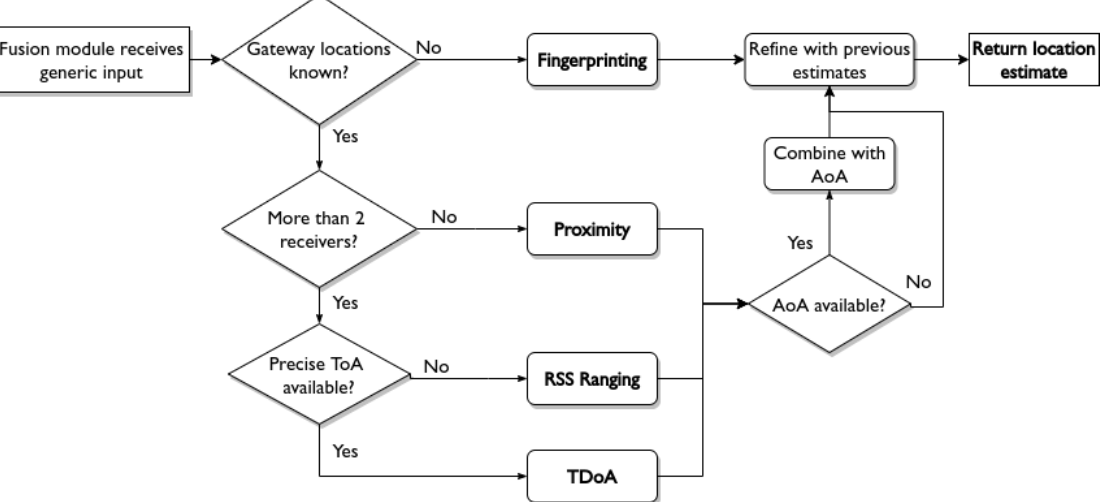
Figure 3. An example on how the fusion module can decide which localization method to use, based on the available input and the configuration that was set up by the